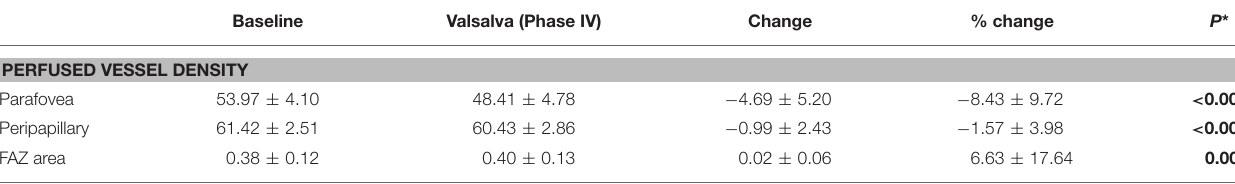
TABLE 2 | Perfused vessel density and foveal avascular zone area at baseline and during Phase IV of the Valsalva maneuver.